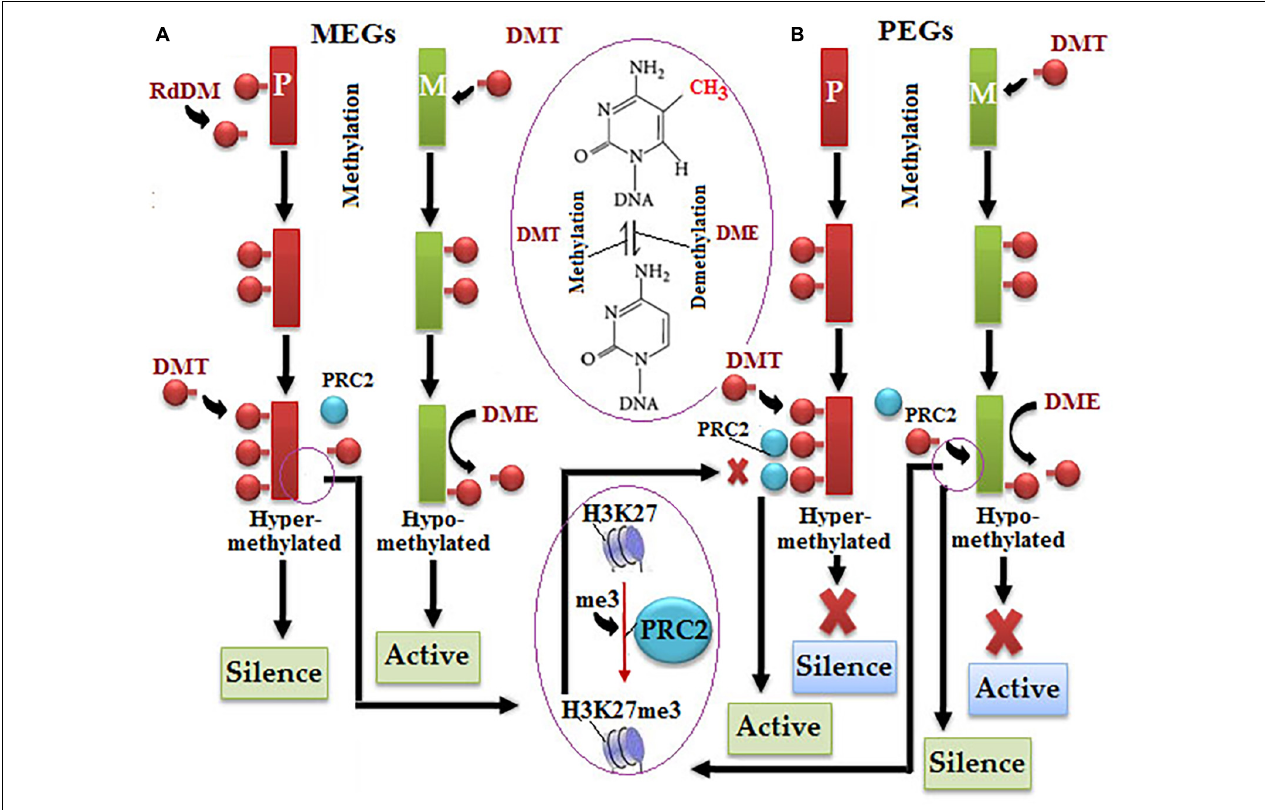
FIGURE 3 | Molecular mechanism of alternative imprinting gene expression: (A) in the maternally expressed imprinted genes (MEGs) pathway, differential methylation of both maternal alleles occurs (green color), i.e., DEMETER (DME) downregulates DNA methylation by the hypomethylation process resulted in parental allele normal expression (red color), but increased methylation by DMT and polycomb repressive complex 2 (PRC2) causes histone methylation resulted in allele suppression, (B) in the paternally expressed imprinted genes (PEGs) pathway, the hypermethylated parental allele switches from the silent to active state under the action of PRC2 due to a halt in methylation by DMT, contrastingly hypomethylated maternal allele switches the active to silent state under the action of PRC2 via histone